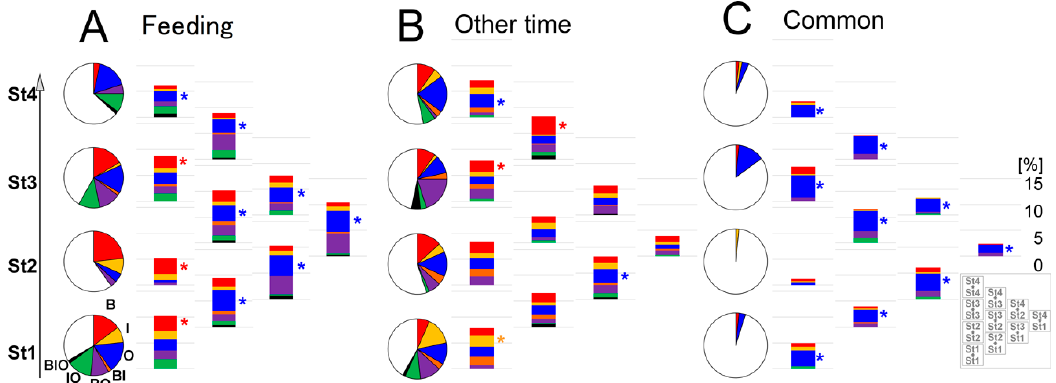
Figure 7. Correlated B-, I-, and O- variable ratios per intra- or inter-stage analysis by LMMs between two time points of feeding / other, day and night. In each specific condition of feeding ( A ), other day time ( B ), or common to both ( C ), pie charts represent the ratio of selected regression-model types, categorized as a single or combined contribution of significant B-, I-, O- variables based on LMMs followed by cAIC in “intra-stage” analysis in each age stage. The right bottom box represents each analyzed stage combination layout of the accumulated bars.